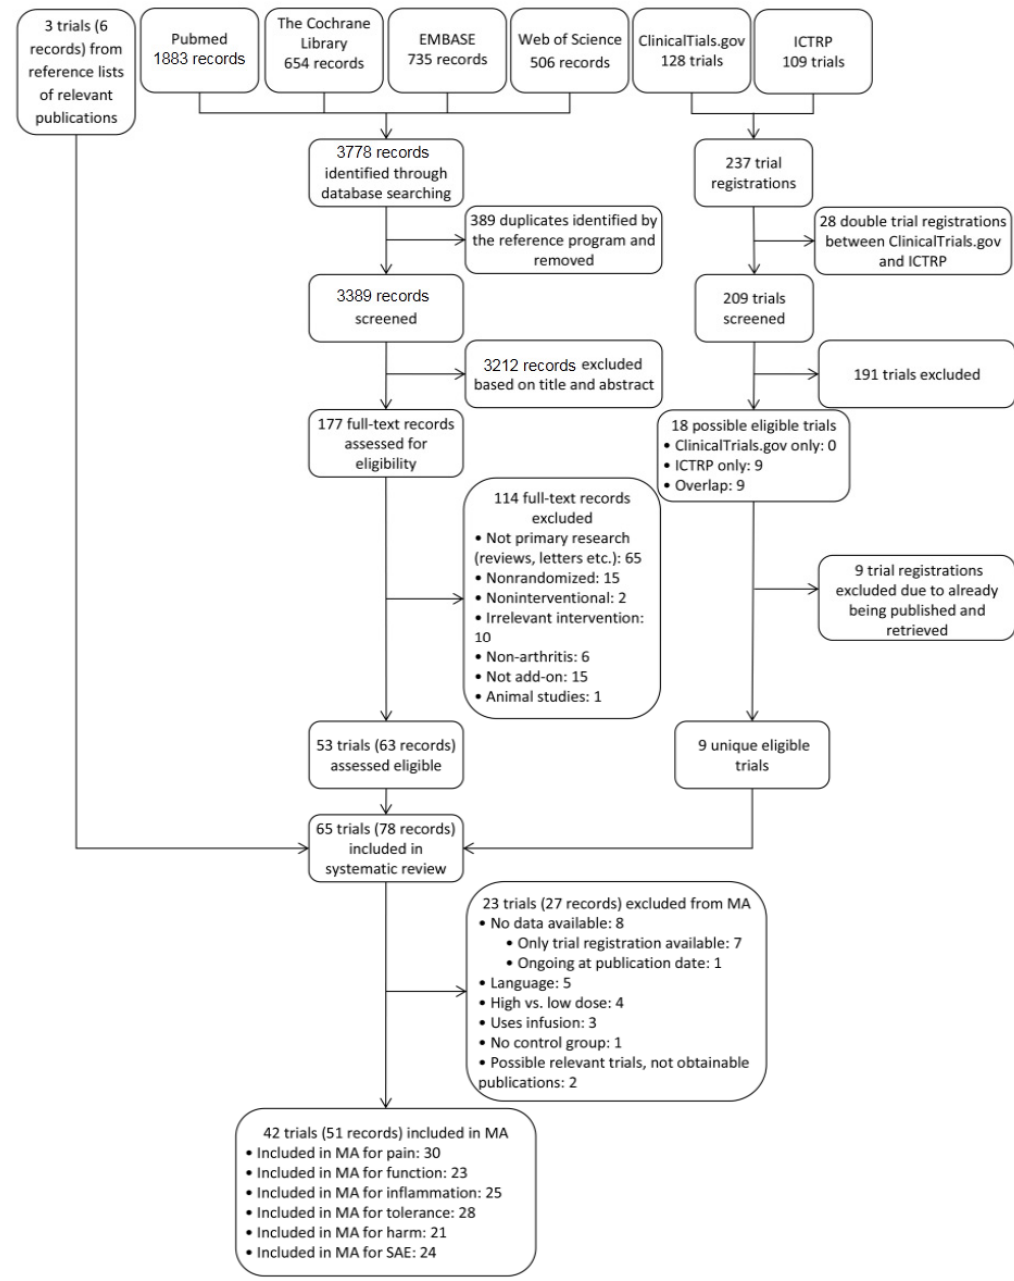
Figure 1. Flow diagram showing the selection of trials. MA: meta-analysis, ICTRP: World Health Organization International Clinical Trial Registry Platform portal, SAE: serious adverse event.